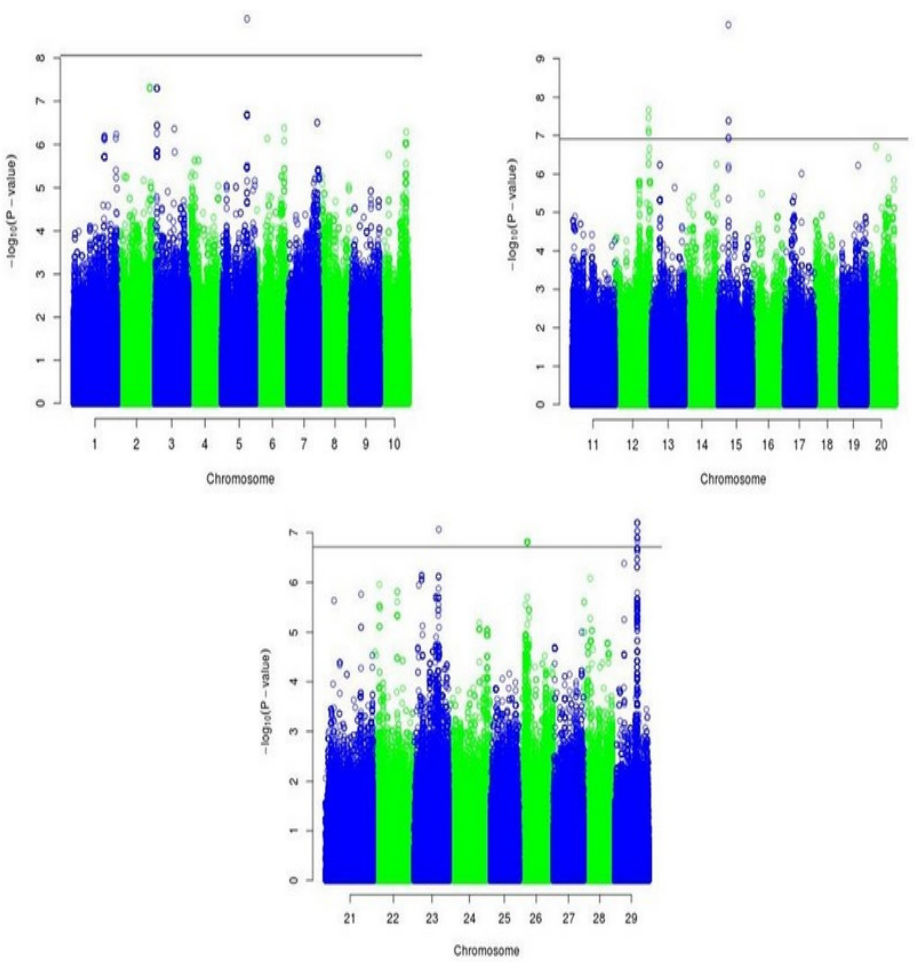
Figure 3. Manhattan plots of − log10 (p) for hind leg circumference in segments 1–3. The horizontal lines represent the thresholds.